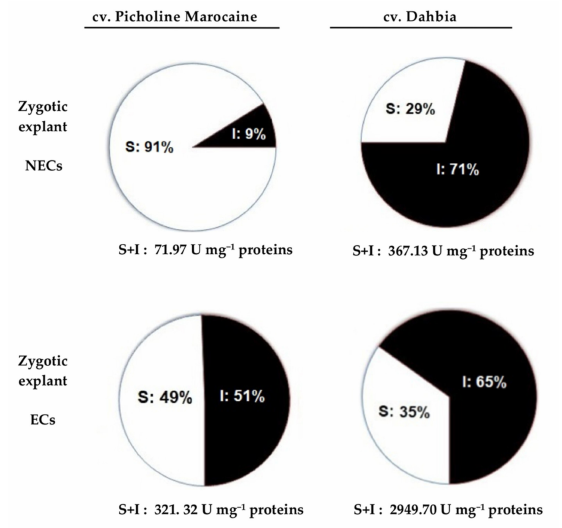
Figure 3. Percentages of peroxidases (POXs) activities (U mg − 1 proteins) tested in soluble (S) and ionically wall-bound (I) enzyme fractions extracted from the nonembryogenic calluses (NECs) and embryogenic calluses (ECs) derived from the zygotic explants of the olive cvs. Picholine Marocaine and